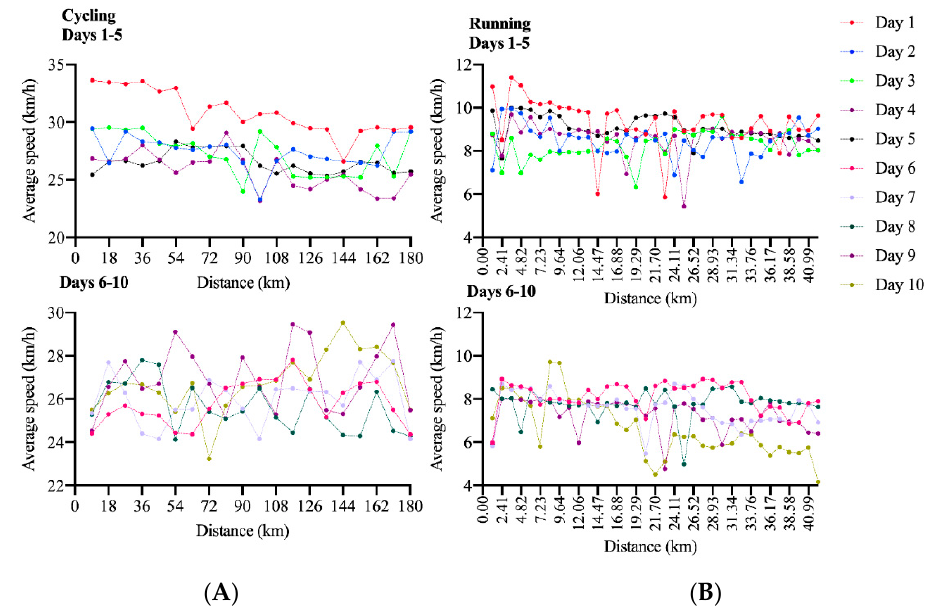
running ( B ) split. Figure 1. Pacing in each of the five days in a Quintuple Iron ultra ‐ triathlon in the cycling ( A ) and